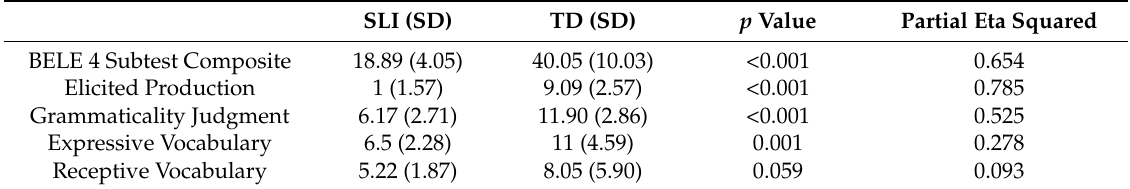
Table 4. Mean BELE scores, with standard deviations, comparison results and partial Eta squared